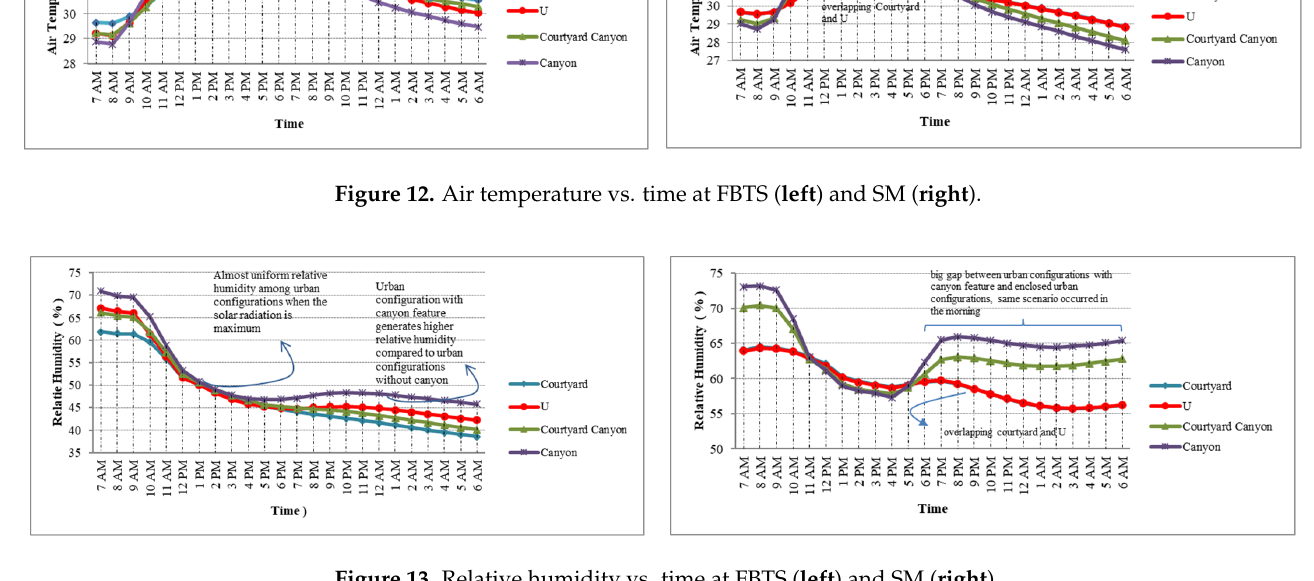
Figure 13. Relative humidity vs. time at FBTS ( left ) and SM ( right ).